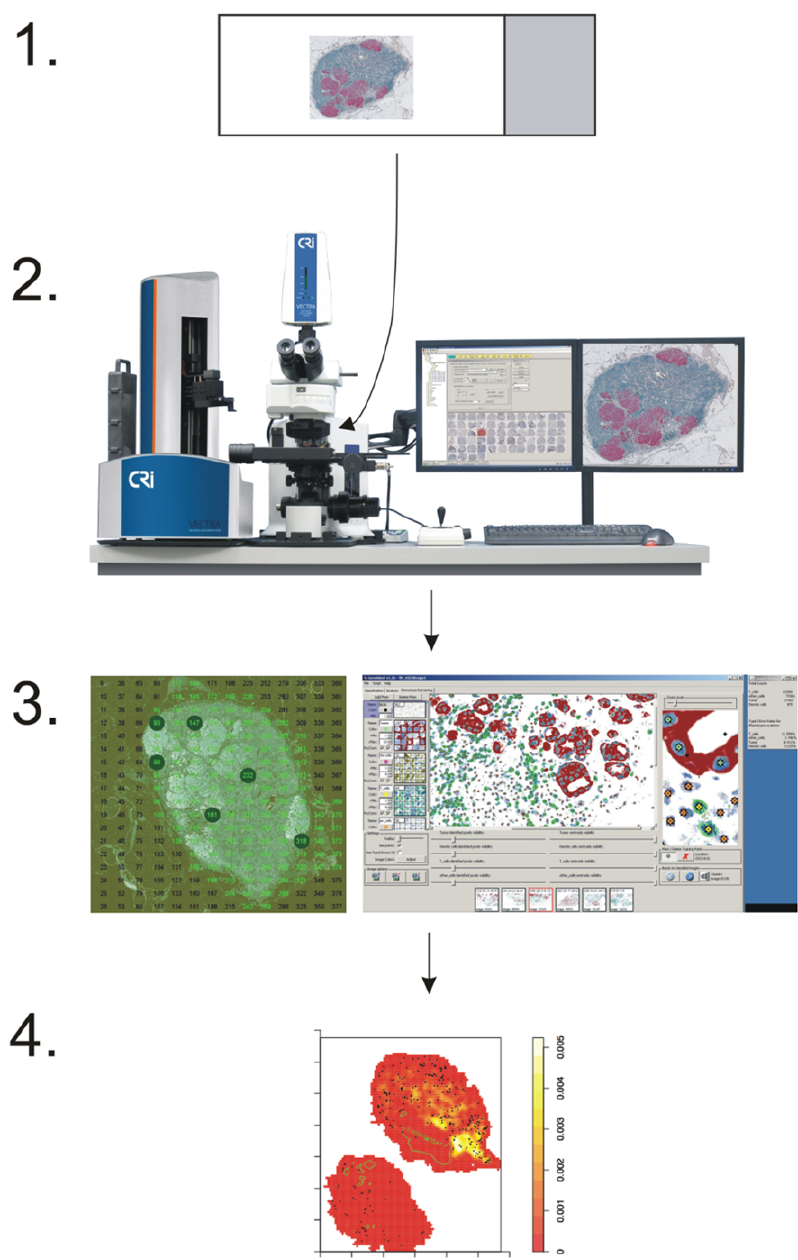
Figure 1. Integrated image analysis approach. Stage 1: multicolor staining of tissue sections. Stage 2: high-resolution spectral imaging and automated scanning of the entire tissue section. Stage 3: machine-learning-based cell identification by GemIdent. Stage 4: numerical and spatial statistical analyses, such as cell densities, distances and distributions.